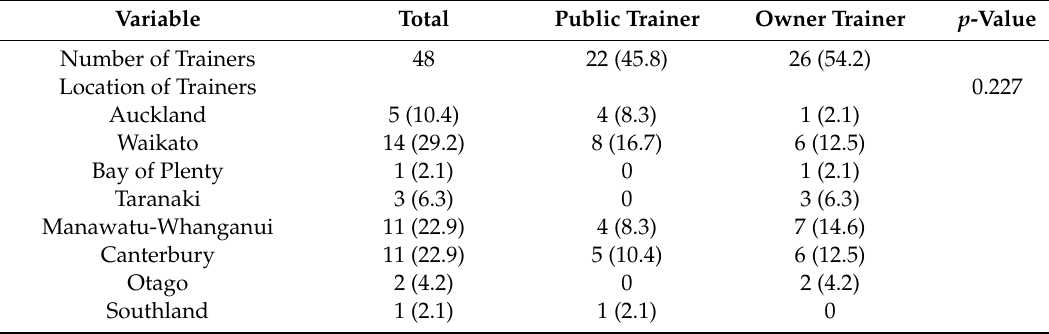
Table 1. Descriptive demographics, facilities used, and training methods of racing greyhounds as reported by 48 trainers from a cross-sectional survey of the training practices of racing